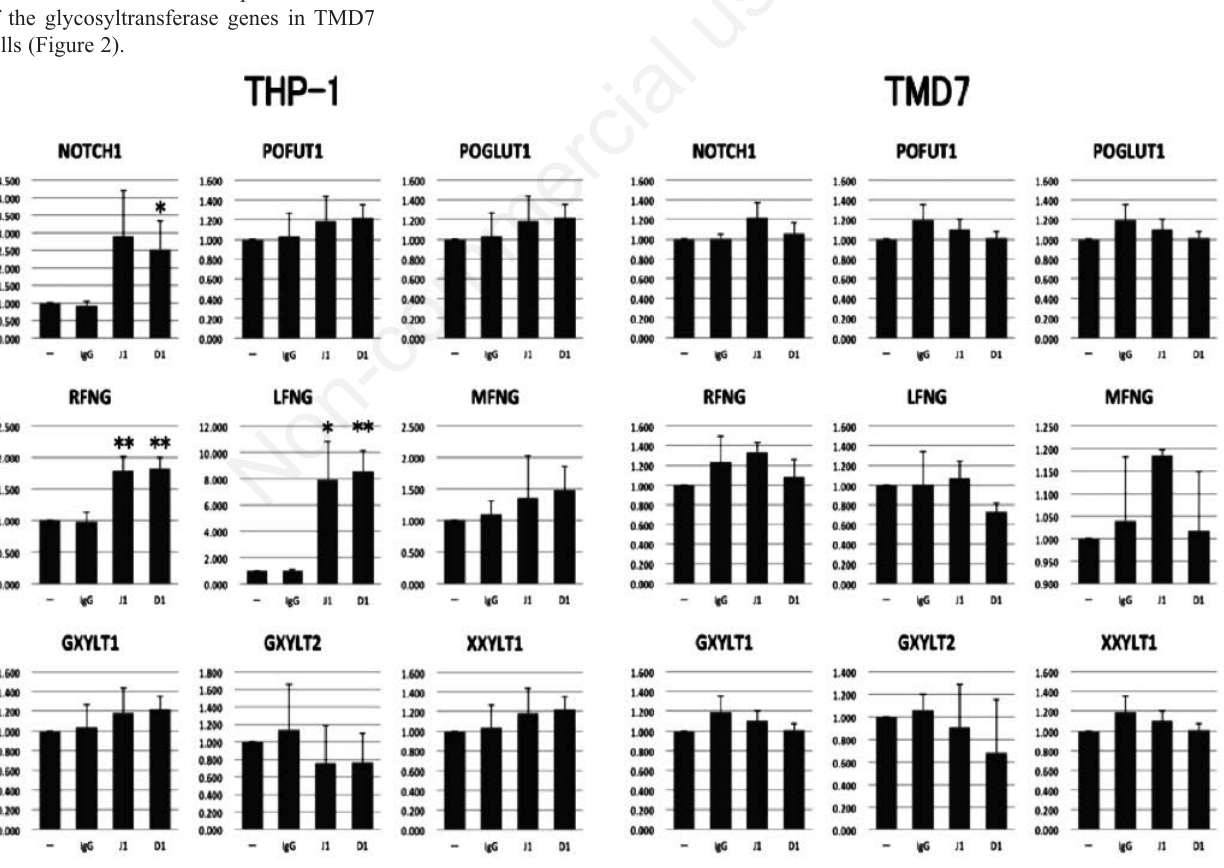
Figure 2. Effects of NOTCH ligand stimulation on the mRNA expression levels of glycosyltransferase genes in THP-1 and TMD7 cells. Cells were cultured in the absence (control marked with -) or presence of human IgG (IgG), JAGGED1 (J1), or DELTA1 (D1). After 24 h, RNA was extracted from the cells and subjected to qRT-PCR analysis. Expression levels were normalized to that of the gene. Numbers indicate the mean fold changes relative to each control from three independent experiments. *P<0.05, **P<0.01, com- pared to the